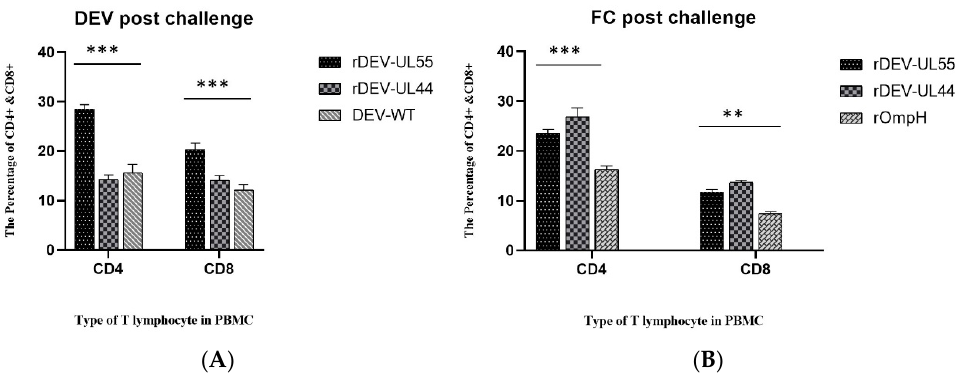
Figure 8. Levels of CD4+ and CD8+ response in survived ducks were analyzed at 7 days post ‐ challenge with lethal DEV ( A ) and P. multocida X ‐ 73 ( B ) in different groups. Statistically significant differences are indicated by (***) p < 0.001, (**) p < 0.01 comparing the recombinant DEV ‐ OmpHs with the DEV ‐ WT or rOmpH group.